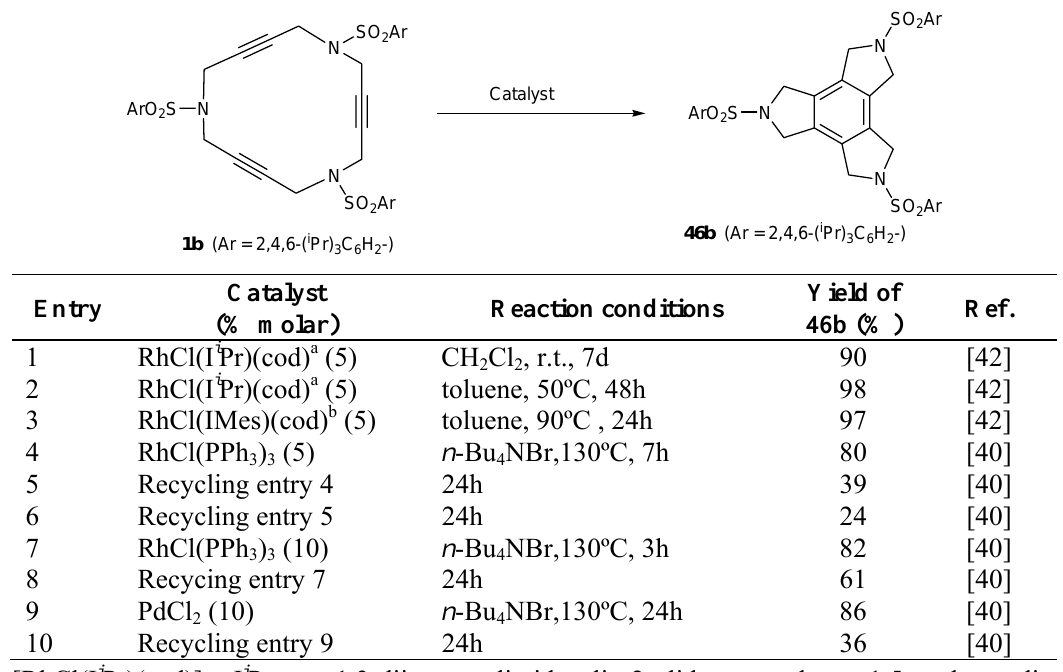
Table 2. Cycloisomerization reactions of macrocycle 1b with different catalytic systems. SO 2 Ar NN N